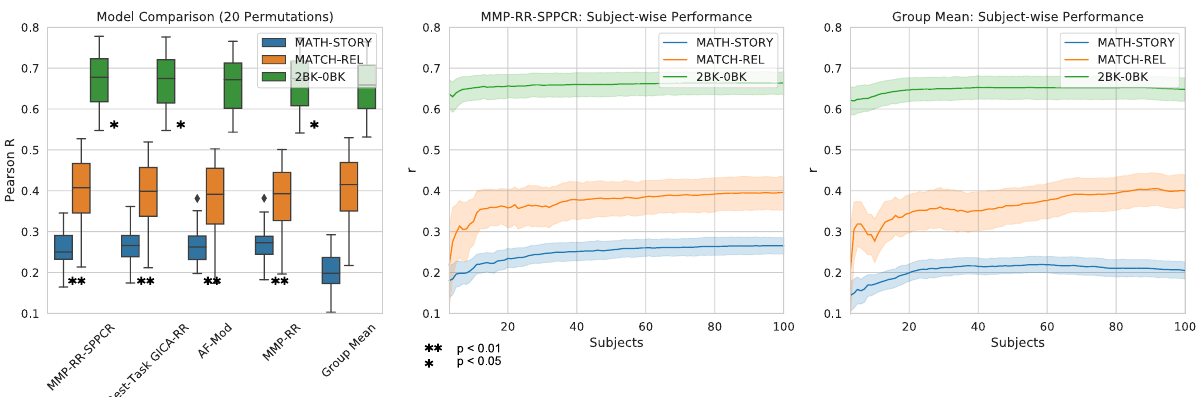
Figure 9. Correlation of cortex-wise score and behavioral task accuracy. ( A ) Comparison of different models investigated in detail shown in Fig. 8. Only Math-Story and 2BK-0BK showed significant correlations using a one-sided corrected resampled t-test compared to Group Mean (significance marked in by *). ( B ) Subject-wise comparison of correlation between model MMP-RR-PCR prediction score and behavioral task performance for 20 permutation depending on the training set size (3–100). ( C ) For comparison, same as B, but for the Group Mean baseline